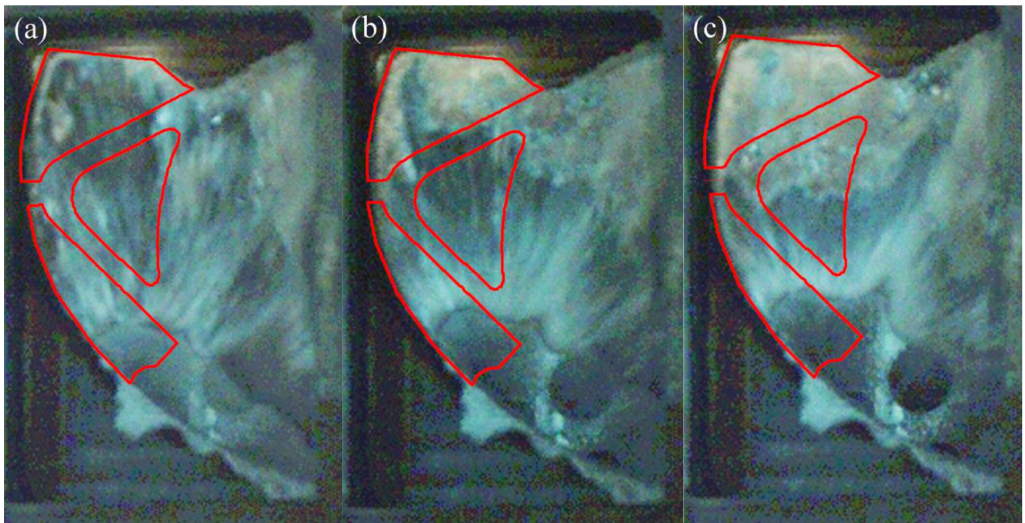
Figure 8. Flow pattern under the fast shot velocity of 1.59 m/s in the left window. ( a – c ) are arranged according to the order of filling.